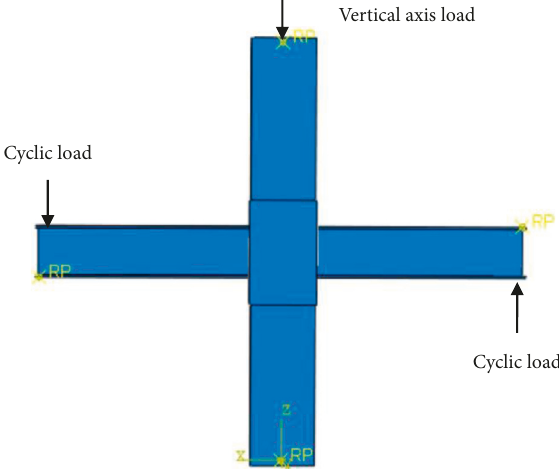
Figure 7: Loading